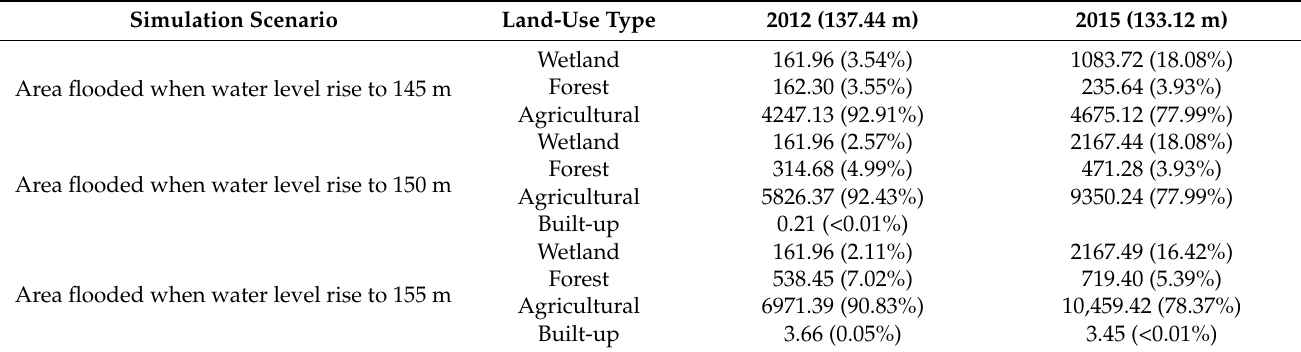
Table 2. Areas flooded during each